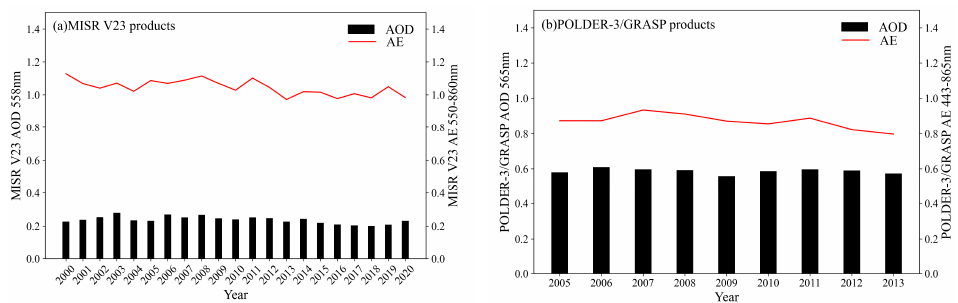
Figure 4. Variation figures of annual mean AOD and AE: ( a ) MISR V23 products; ( b ) POLDER- 3/GRASP products.